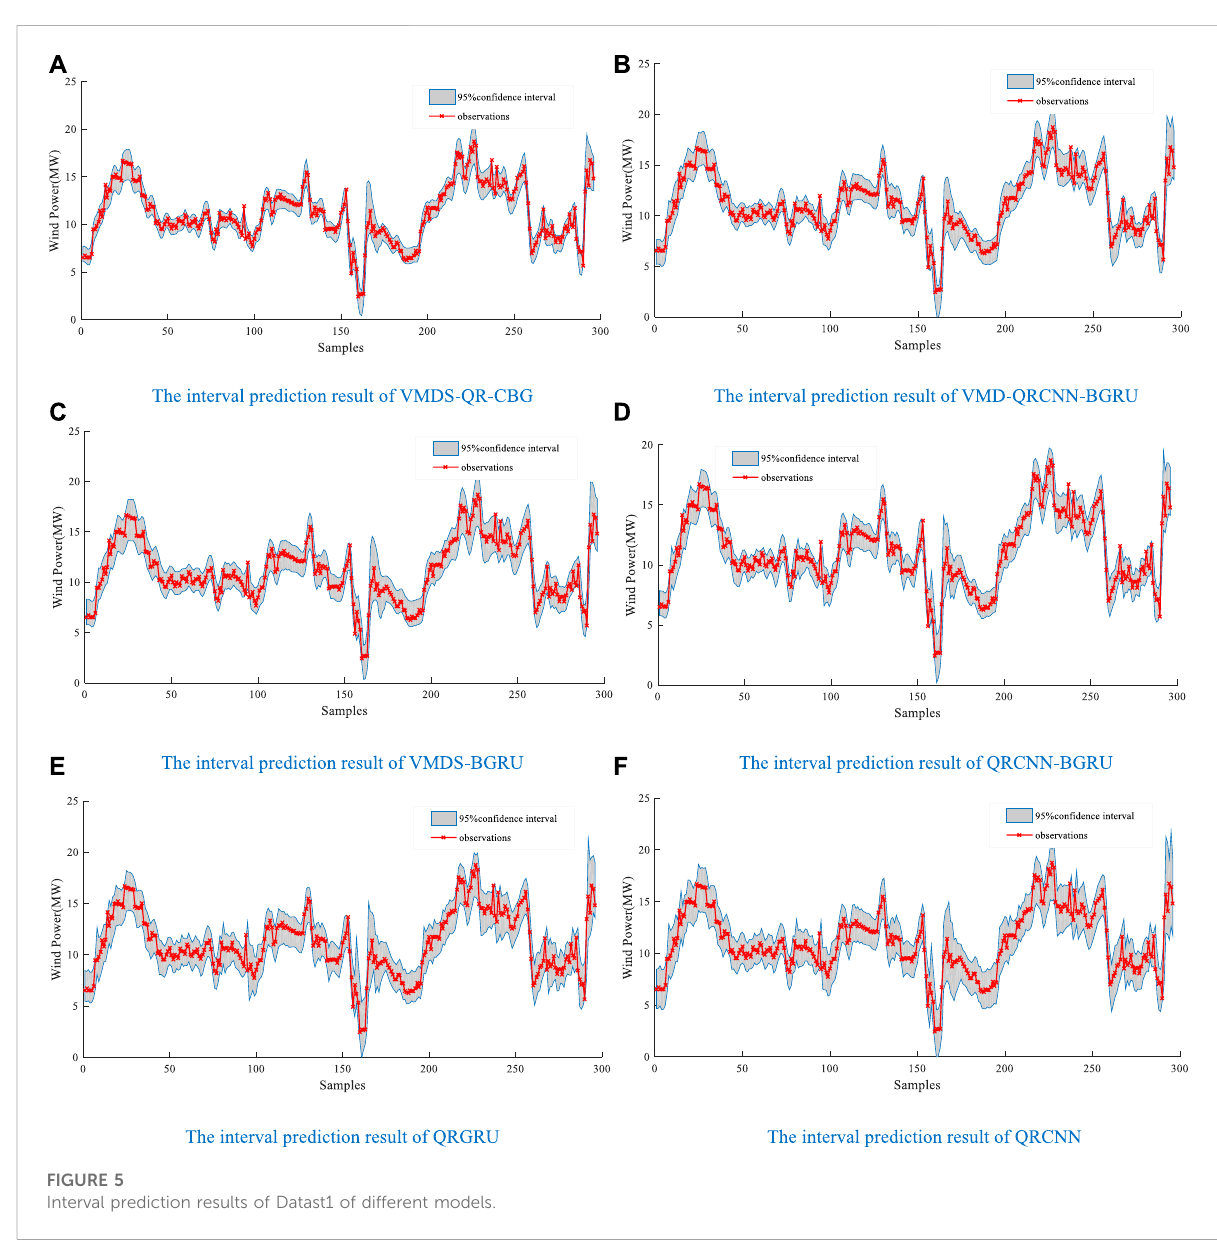
FIGURE 5 Interval prediction results of Datast1 of different models.